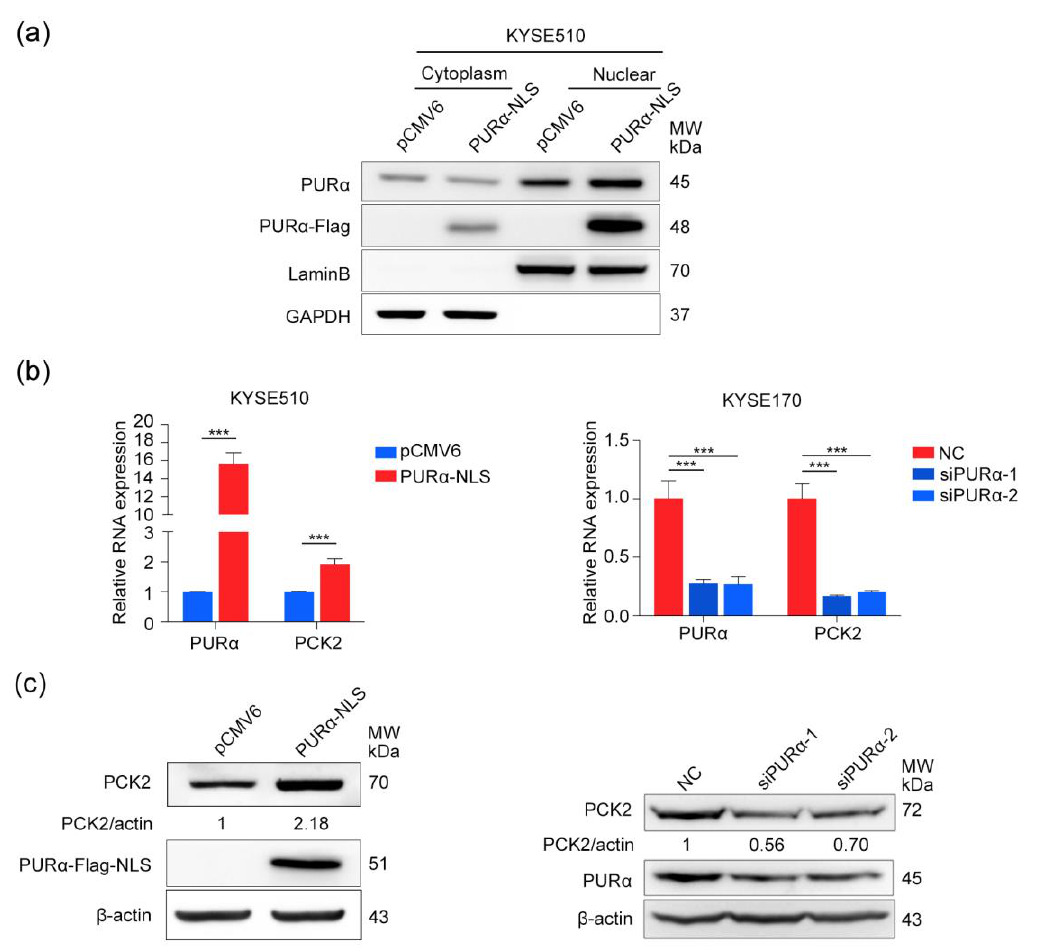
Figure 9. PUR α activates the transcription and expression of PCK2. ( a ) The cytoplasmic / nuclear protein level of PUR α in the KYSE510 cells of overexpressing pCMV6-PUR α -NLS. ( b ) The mRNA level of PCK2 in the KYSE510 cells of overexpressing pCMV6-PUR α -NLS or KYSE170 cells with PUR α knockdown was detected by qPCR. ( c ) The protein level of PCK2 in the KYSE510 cells of overexpressing pCMV6-PUR α -NLS or the KYSE170 cells with PUR α knockdown was verified by Western blotting. n = 3. ***, p < 0.001.